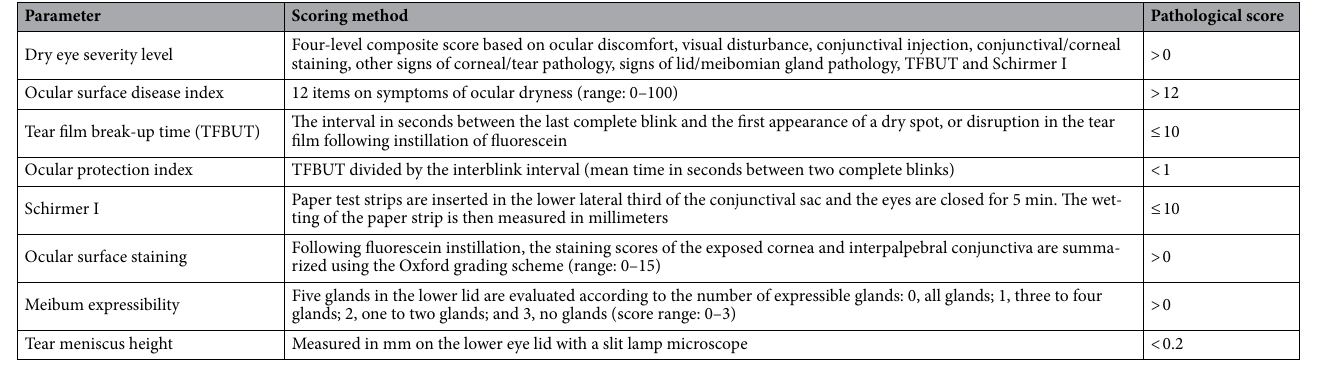
Table 5. Ophthalmological work-up for dry eye